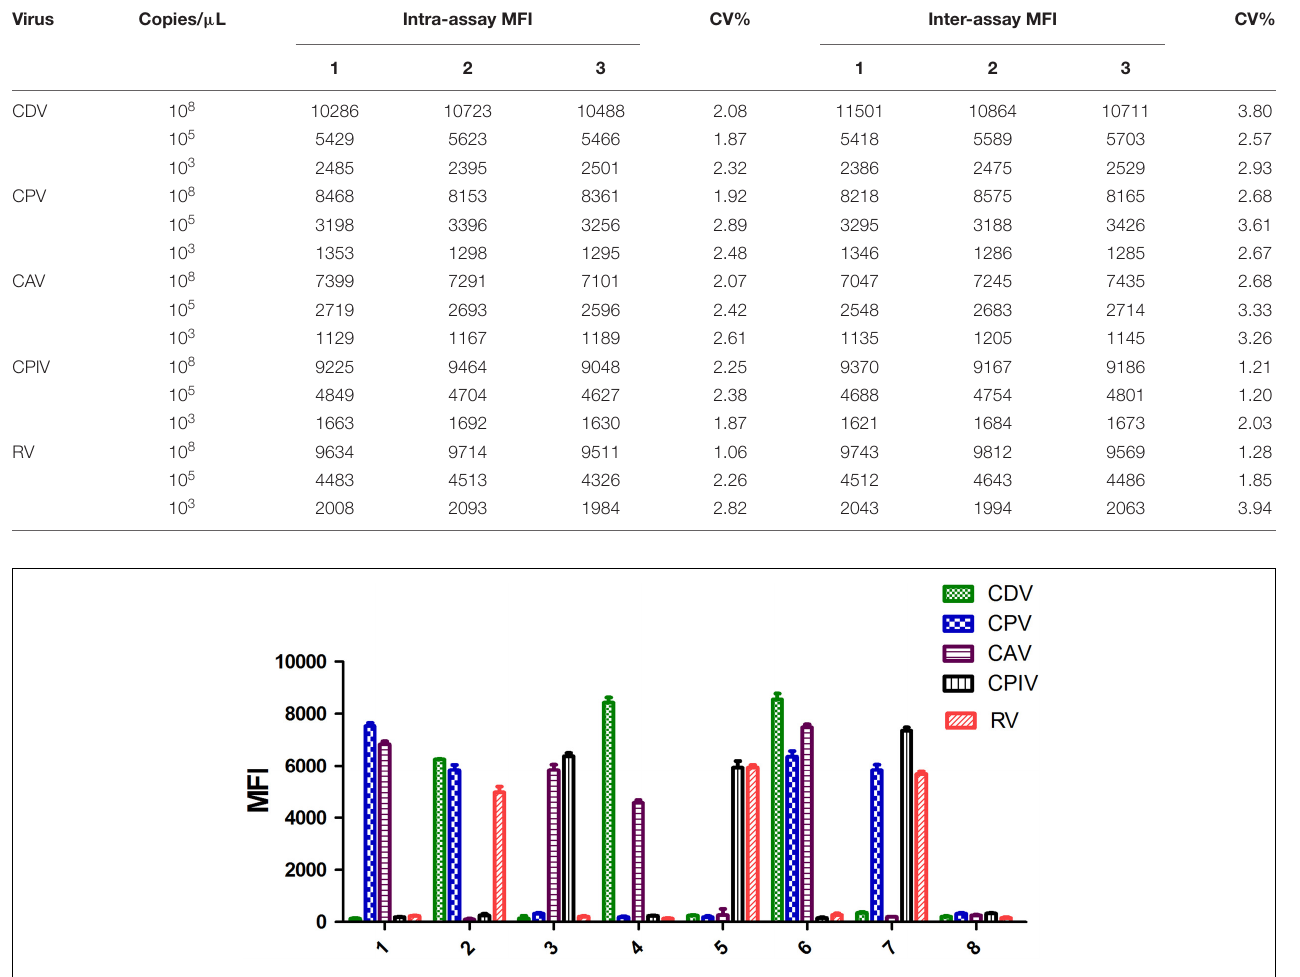
FIGURE 3 | Validation of the artificial mixed infection samples. 1, CPV and CAV positive sample; 2, CDV, CPV, and RV positive sample; 3, CAV and CPIV positive samples; 4, CDV and CAV positive sample; 5, CPIV and RV positive sample; 6, CDV, CPV, and CAV positive sample; 7, CPV, CPIV, and RV positive sample; 8, negative